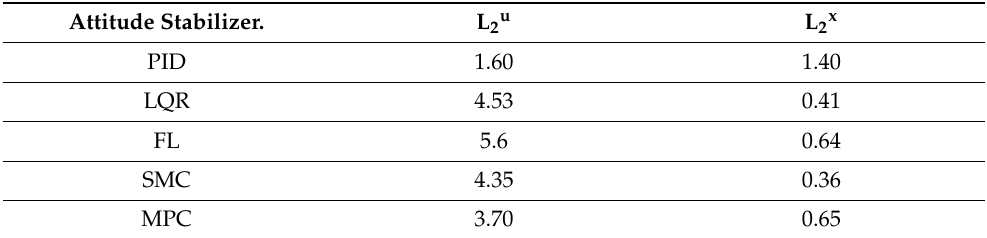
Figure 8. Euler angles signals [ φ ( t ) , ϑ ( t ) , ψ ( t ) ] of the controlled attitude system (blue): MPC-based Attitude Stabilizer (red). Table 3. Evaluation parameters: sum of L 2 norms of the controller commands signals, L 2 u , and sum of L 2 norms of the Euler angles error signals, L 2x